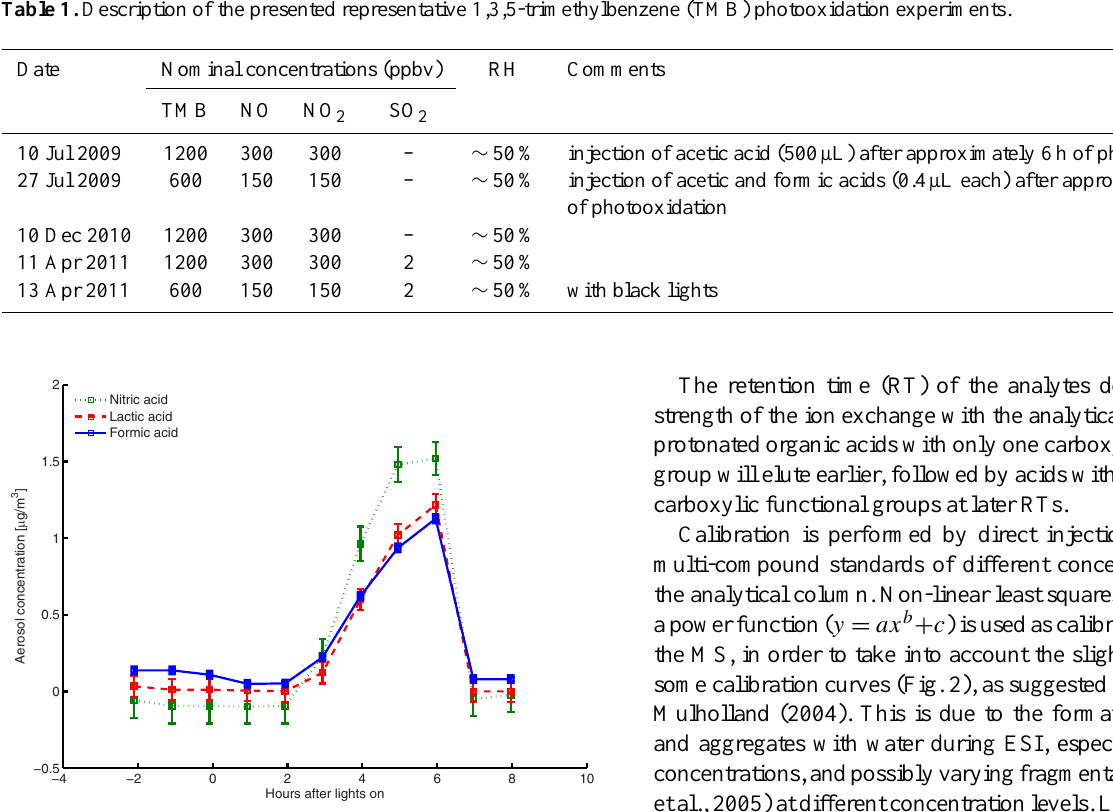
Figure 1. No breakthrough of the gas phase to the aerosol collector (AC) was observed when a filter was placed 6h after lights on in the aerosol sampling line during a 1200ppbv 1,3,5-trimethylbenzene (TMB) photooxidation